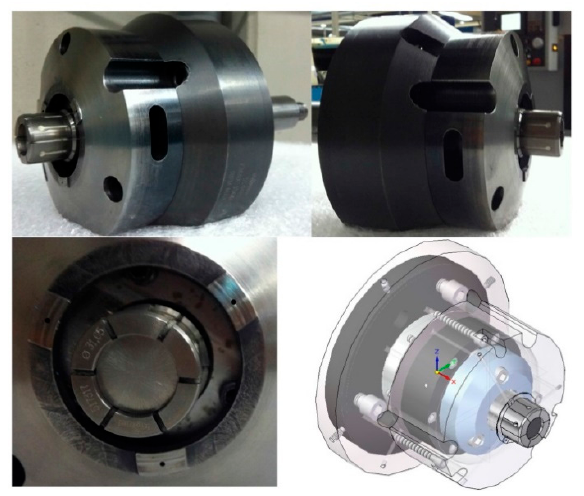
Figure 19. Variance of clamping force.